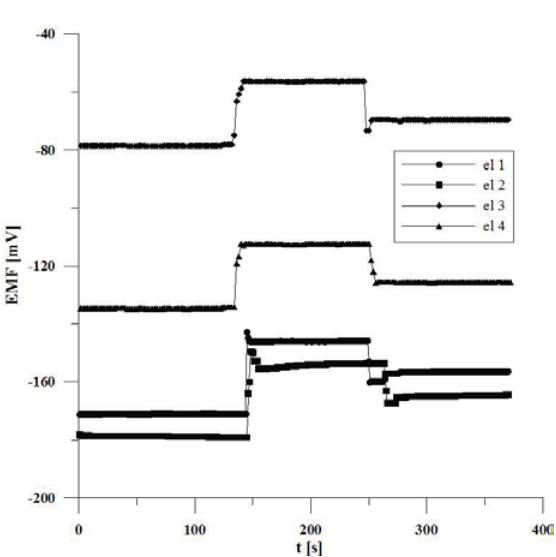
Figure 4. Selectivity coefficients (log K pot determined by FIM